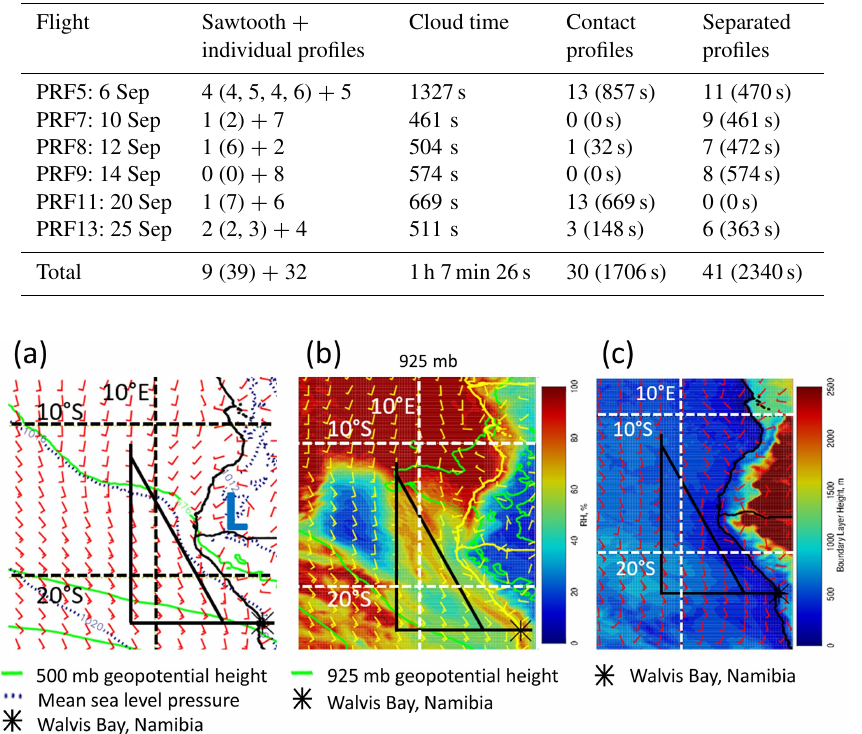
Figure 2. Zero-hour European Centre for Medium-Range Weather Forecasts reanalysis at 12:00UTC on 6 September 2016 for (a) mean sea level pressure, 500mb geopotential height, and surface wind; (b) 925mb relative humidity, geopotential height, and wind; and (c) boundary layer height and 900mb wind (https://bocachica.arc.nasa.gov/ORACLES/, last access: 22 March